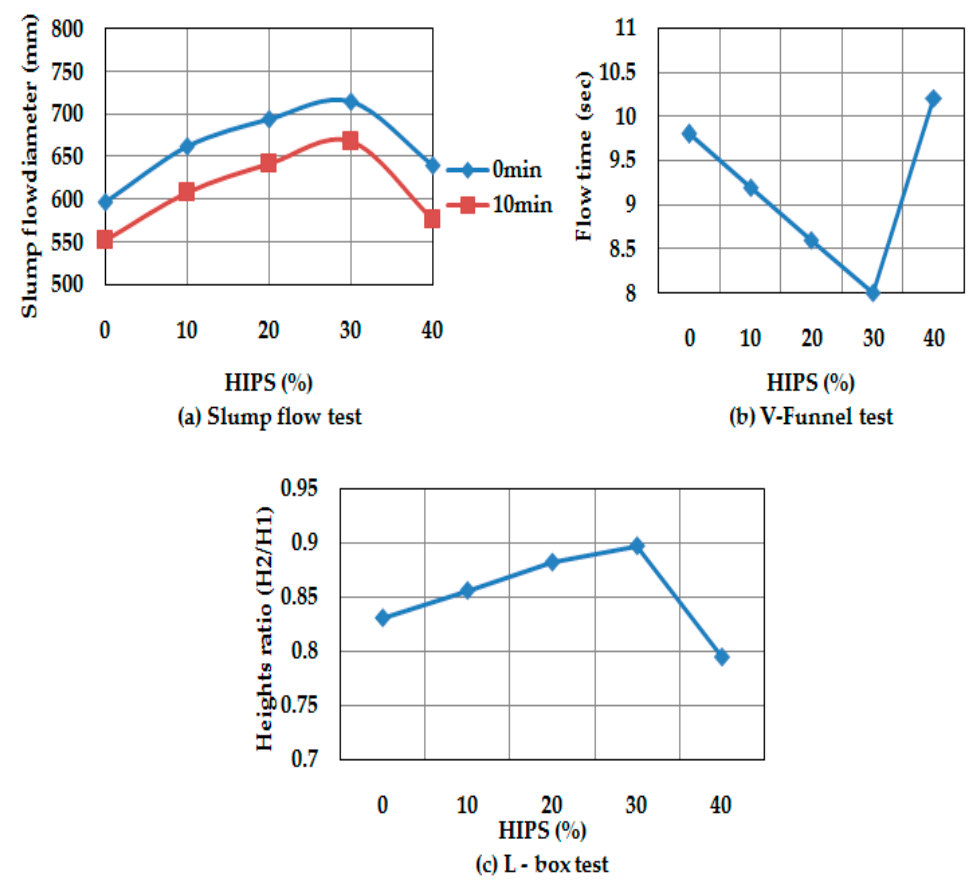
Figure 7. Rheological behavior of SCC with HIPS aggregates . 239